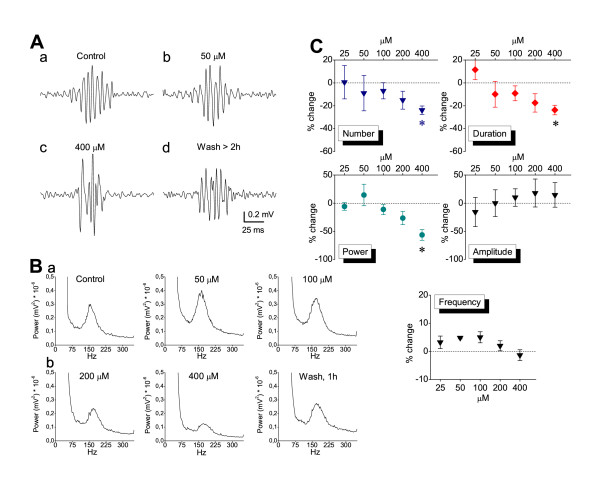
Effects of phenobarbital on Ripple oscillation. A. Examples of ripple oscillation obtained from one recording session showing that phenobarbital reversibly shortened ripple episode only at 400 μM (asterisks, paired t-tests, P < 0.05). B. Power spectra obtained from different times of a single experiment illustrating the reduction in ripple power only at high drug concentrations (200 and 400 μM). C. Diagrams of collective data for the different measures of the ripple oscillation. Note that the reducing effect of phenobarbital on number, duration and ripple power was statistically significant (asterisks, P < 0.05) only at the highest concentration of 400 μM. Measures of the above variables (except power) at the five drug concentrations were obtained from 2, 3, 7, 5 and 9 slices. Values of power were obtained from 4, 7, 12, 9 and 12 slices.